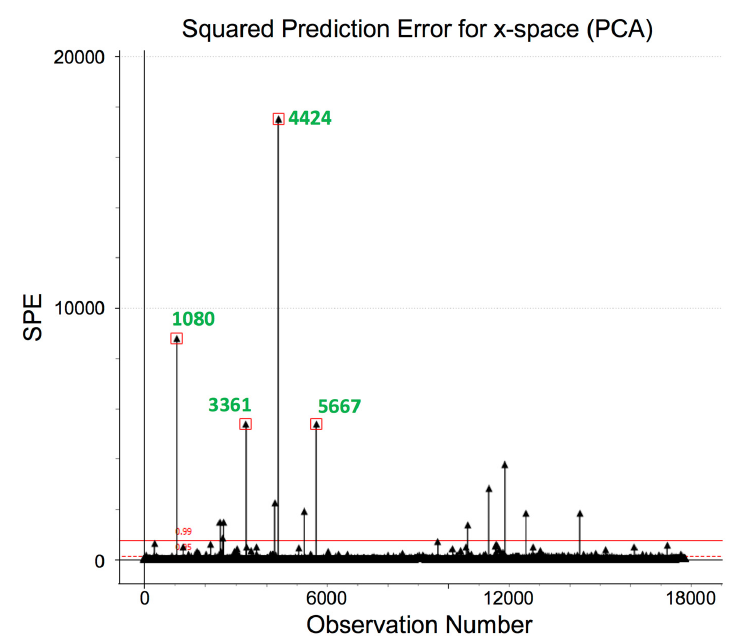
Figure 4. SPE for all observations in the dataset with the summary variables and critical to quality characteristics (CQCs) for a principal component analysis (PCA) model fitted with two LVs [R 2 (X) = 17%], SPE 95% (dotted red line) and 99% (continuous red line) confidence limits, and the four observations with highest SPE values highlighted.